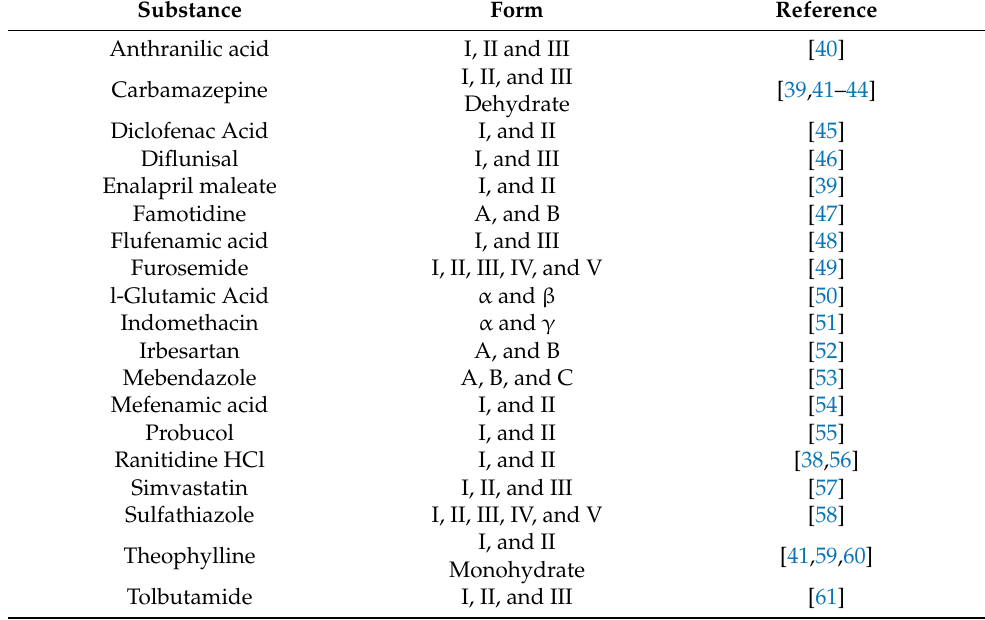
Table 1. List of published papers of substances with different polymorphs investigated with terahertz